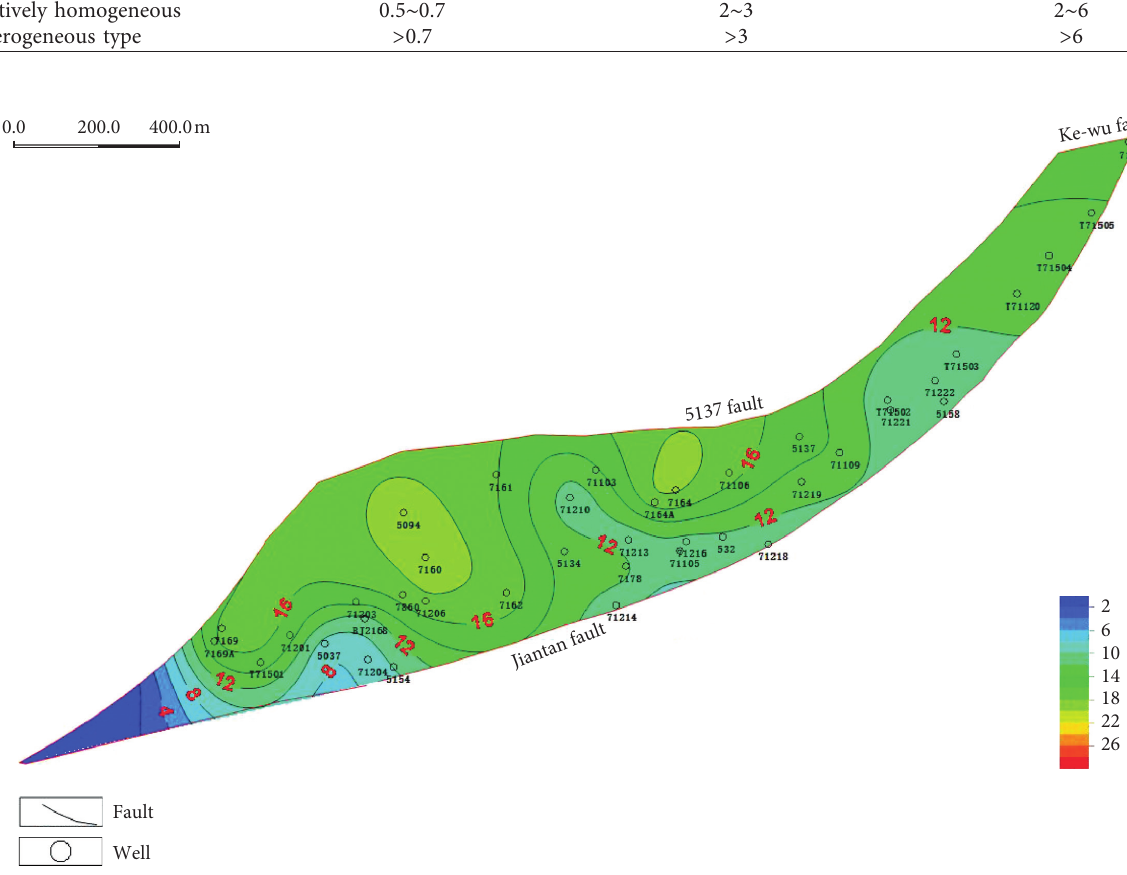
Figure 2: Permeability contour map of K